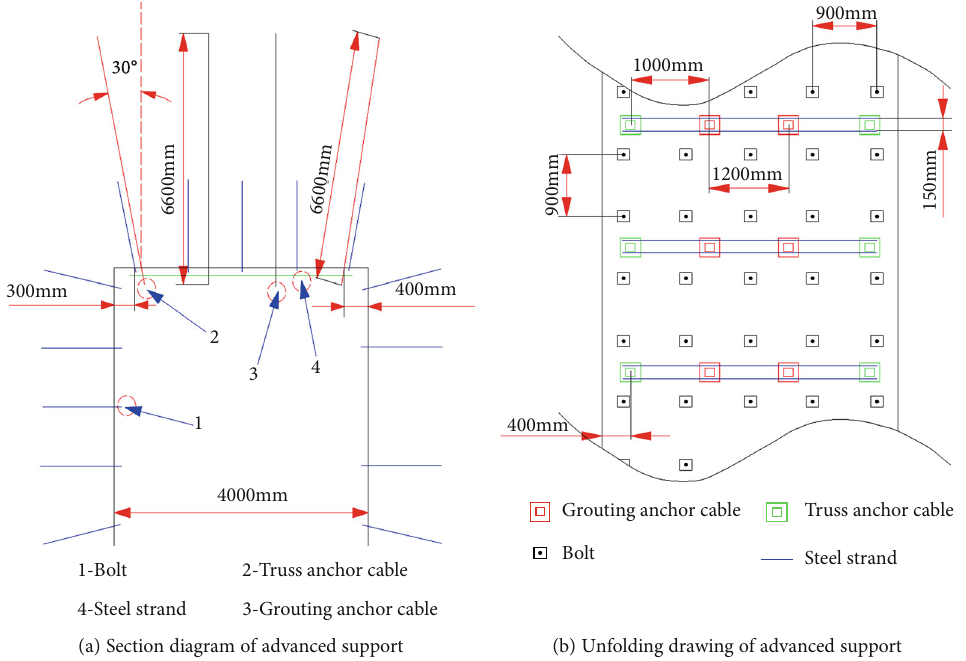
Figure 17: Schematic diagram of advanced support scheme design.